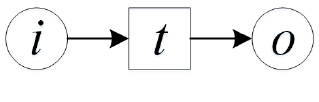
Figure 3. CPN model of PS